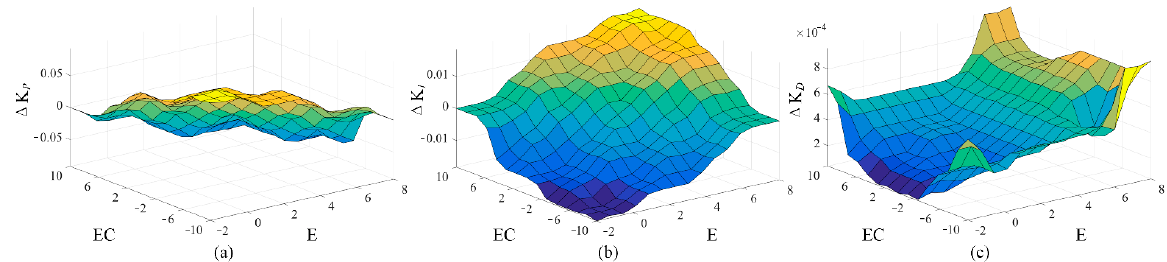
Figure 11. Defuzzification surfaces under different inputs: ( a ) the defuzzification surfaces of Δ KP under different inputs; ( b ) the defuzzification surfaces of Δ KI under different inputs; ( c ) the defuzzification surfaces of Δ KD under different inputs.